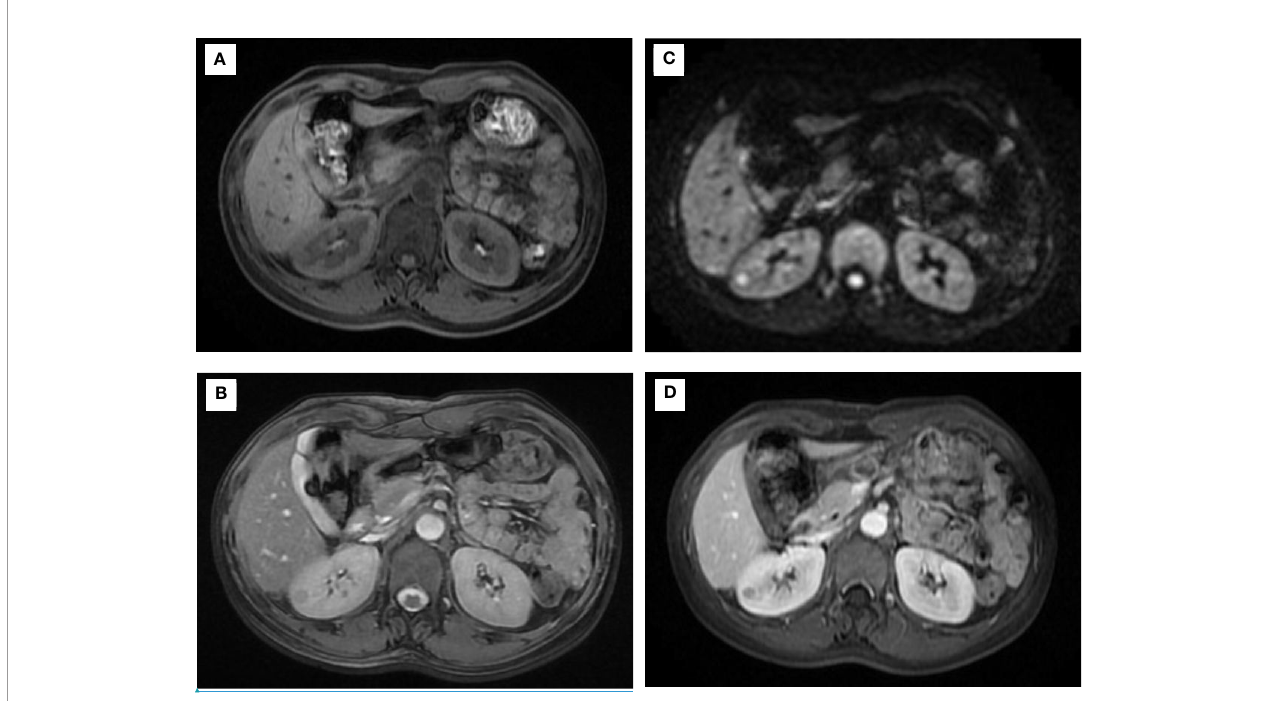
FIGURE 3 | Magnetic resonance imaging (MRI) images of Patient No. 8. Signals of (A) T1, (B) T2, and (C) Diffusion-weighted images of non-contrast MRI. Signal of (D) arterial phase of contrast